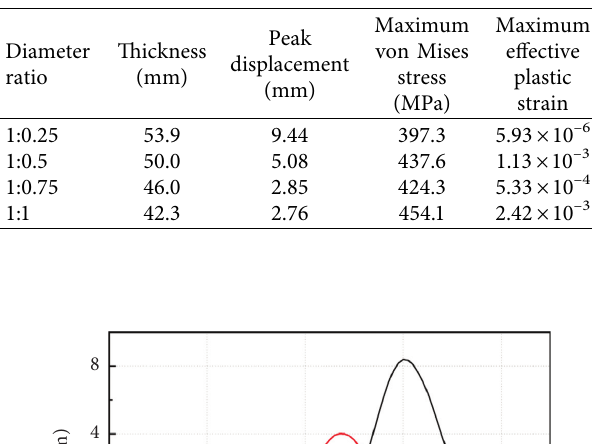
Figure 19: The mid-span displacement time history curve of the EBD under the different explosive quantities.